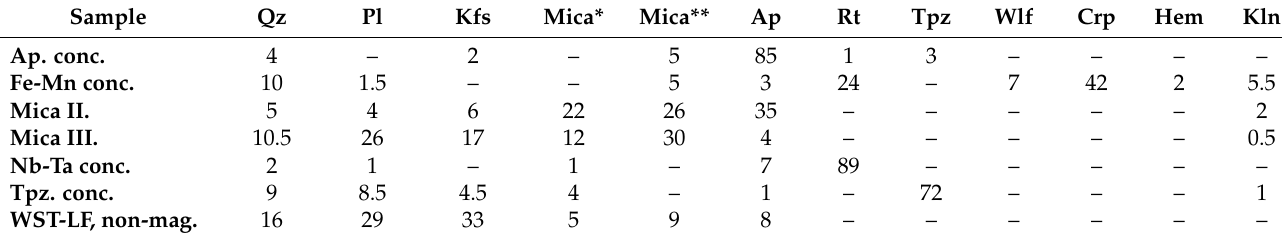
Table 2. Results semiquantitative determination of mineral phases in respective concentrate using Rietveld refinement. Qz = quartz, Pl = plagioclase (structural model of albite was used), Kfs = K-feldspar (structural model of microcline was used), mica* (structural model of zinnwaldite—Li-mica from siderophyllite-polylithionite series—was used), mica** (structural model of muscovite was used), Ap = apatite, Rt = rutile, Tpz = topaz, Wlf = wolframite, Crp = cryptomelane, Hem = hematite, Kln =